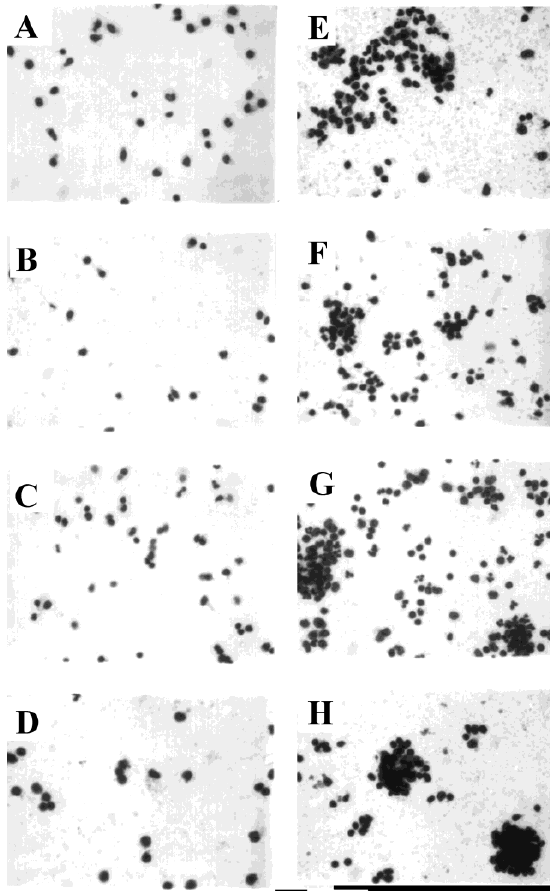
Figure 6. Cell cluster formation by sham-exposed and influenza virus-exposed PBMC (10× image). PBMC were sham-exposed ( A – D ) or exposed to influenza virus ( E – H ). Cultures were stained and examined by light microscopy at 40× after 1 h ( A , E ), 4 h ( B , F ), 24 h ( C , G ), and 72 h ( D , H ). Representative fields are shown.